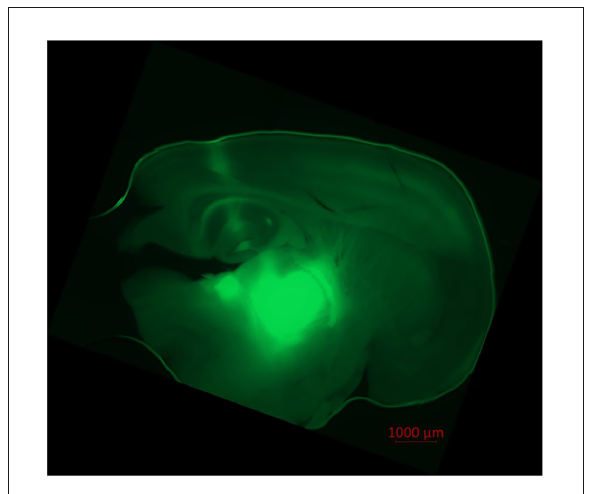
FIGURE1 Injection of AAV1.hSyn.ChR2(H134R)-eYFP.WPRE.hGH-solution led to ChR2/eYFP expression in thalamocortical relay neurons and their projection to the cortex. Fluorescence (eYFP) is prominent in the thalamic ventrobasal complex, surrounding thalamic tissue, axons of thalamocortical relay neurons and their dentrites in cortical lamina IV, V, and VI. Slight fluorescence is observable in the hippocampus and the puncture channel. No transduced neurons were found in the cortex itself. Recorded in fluorescence microscopy (Axio Observer Z.1, fluorescence filter no. 46 HE, ZEN software, Zeiss, Oberkochen,